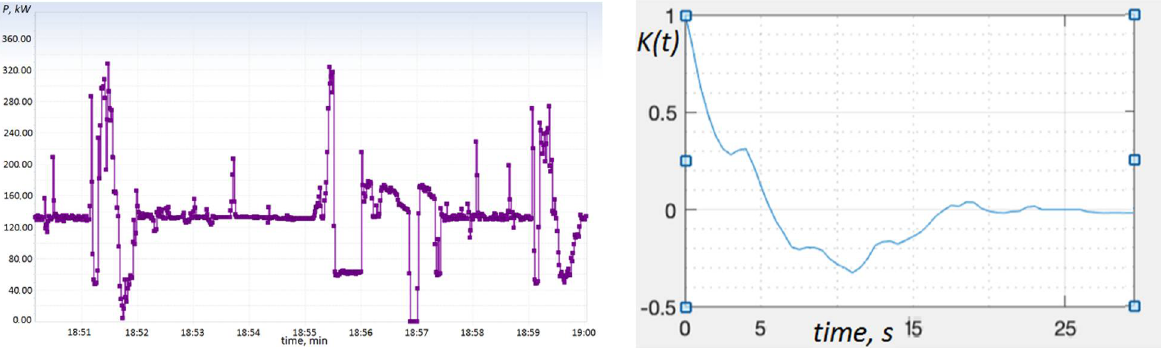
Figure 7. Fragment of the curve of active power consumption overhead crane with a VFD and his NCF.